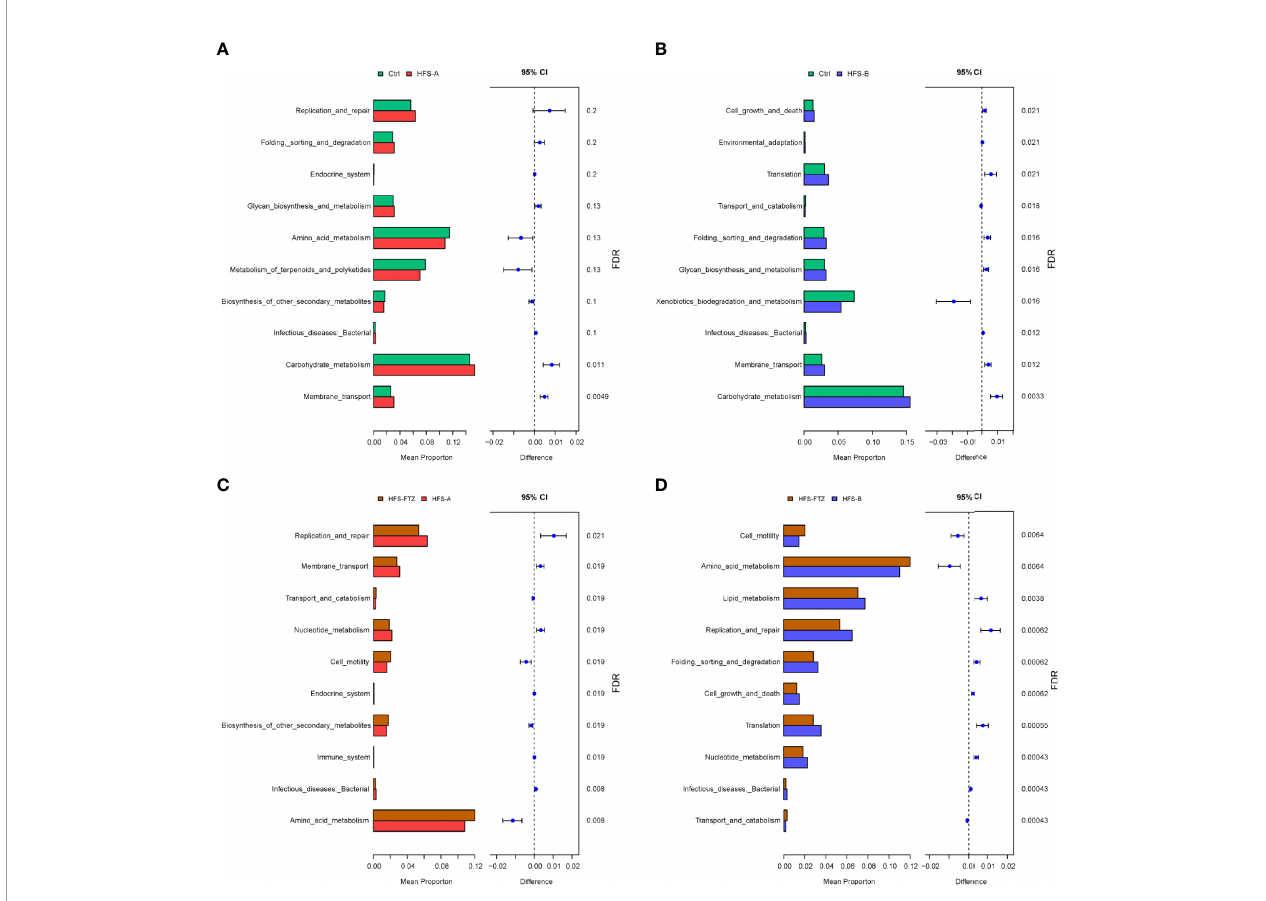
FIGURE 5 | KEGG metabolic pathway analysis of differential functional genes. (A) Functional differences between the Ctrl and HFS-A groups. (B) Functional differences between the Ctrl and HFS-B groups. (C) Functional differences between the HFS-FTZ and HFS-A groups. (D) Functional differences between the HFS- FTZ and HFS-B groups. KEGG, Kyoto Encyclopedia of Genes and Genomes; HFS, high fructose and high